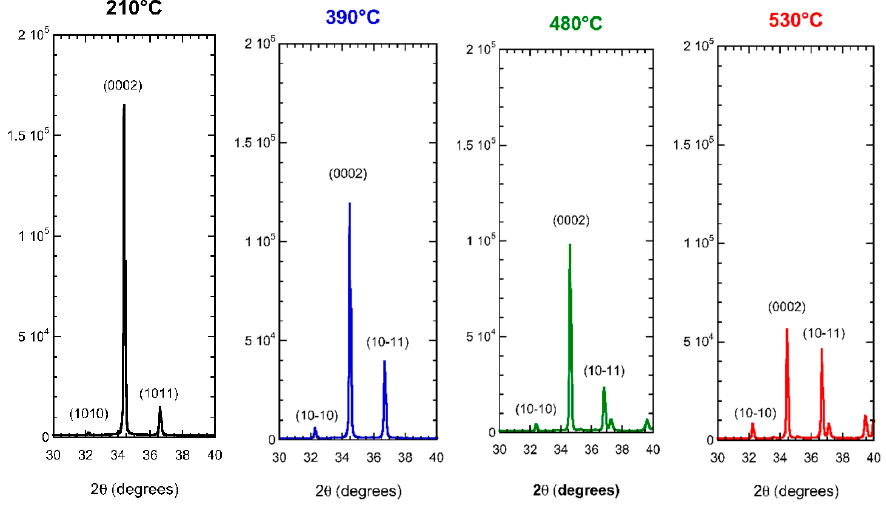
Figure 6. XRD patterns acquired on polished surfaces, on the upper horizontal surface of the Mg-Ni samples forged at increasing temperatures.